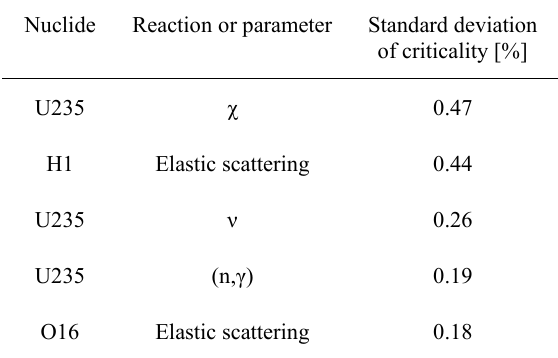
Table 7. The standard deviation of criticality arising from each reaction obtained from the nearest covariance matrix Nuclide Reaction or parameter Standard deviation of criticality [%] U235 χ 0.47 H1 Elastic scattering 0.44 U235 ν 0.26 U235 (n,γ) 0.19 O16 Elastic scattering